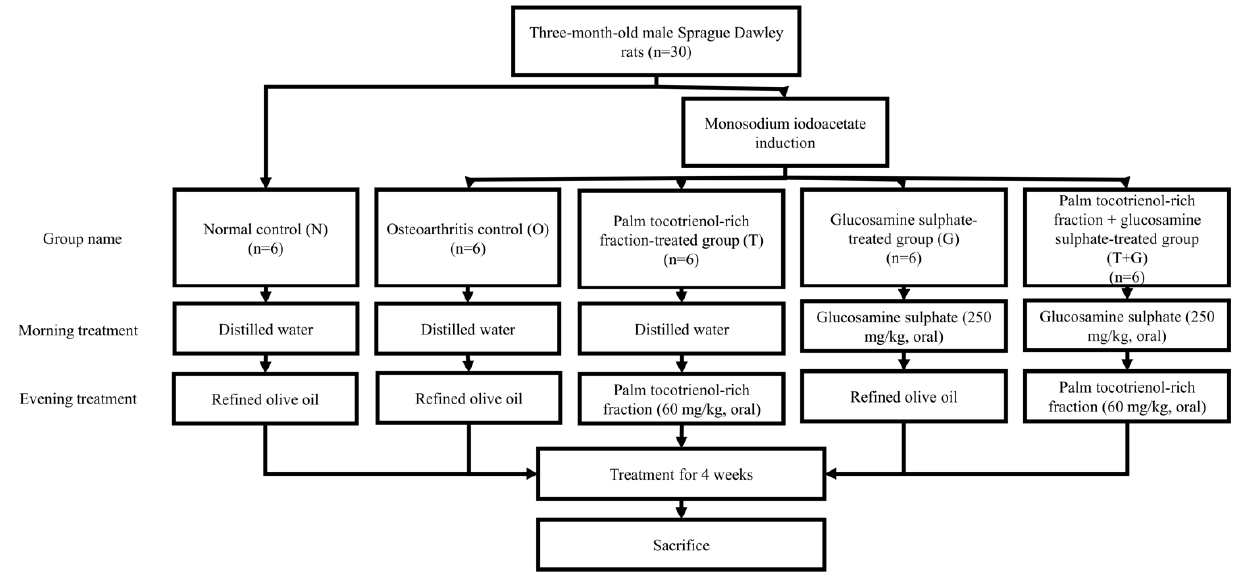
Figure 1. Treatment regimens of the rats in this study.